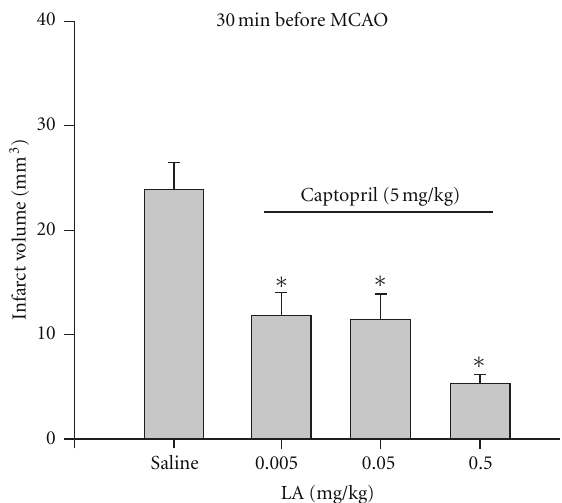
Figure 2: E ff ect of pretreatment (30 minutes before MCAO) with either saline ( n = 5) or co-administration of captopril and lipoic acid ( n = 6/group) on infarct volume (mm 3 ) calculated from TTC- stained Imm thick coronal sections throughout the extent of the infarct following I/R. Each bar represents the mean ± S.E.M. and ∗ indicates significance ( P ≤ 0 . 05) from the saline control group ( n = 4–7/group).